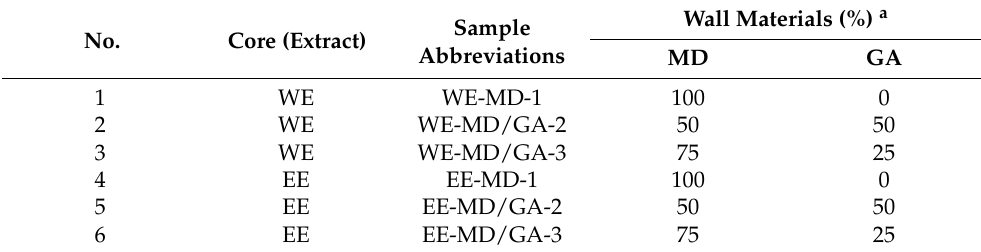
Table 1. Wall material formulations for